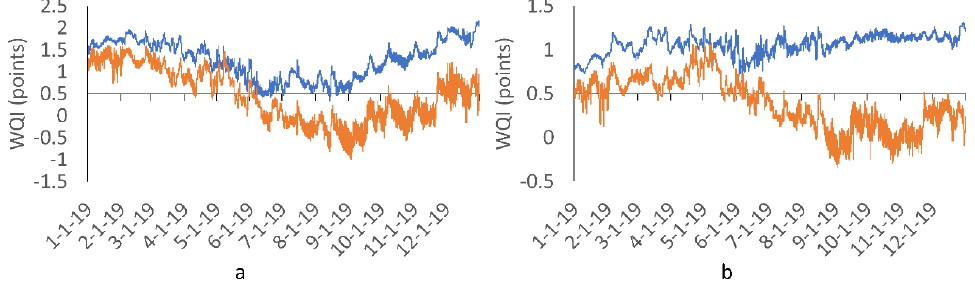
Figure 9. Variants of WQI of Suceava River upstream (blue line) and downstream (orange line) in 2019 (temporal evolution based on hourly data): ( a ) rectified WQI; ( b ) partial WQI.